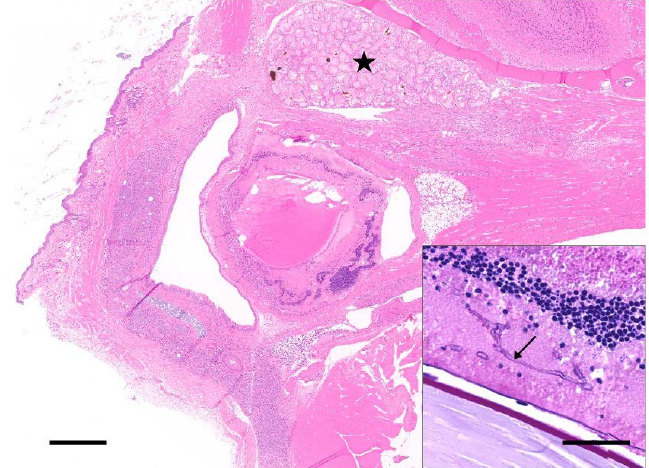
Figure 4. Severe ocular and periocular lesions after retro-orbital bleeding. Example of a severe case of ocular and periocular damage associated with retro-orbital bleeding in a mouse. The eye is small and shrunken ( phthisis bulbi ) with marked intraocular inflammation and intralesional fungal hyphae (black arrow, inset). The periocular tissues are severely inflamed and the Harderian gland is diffusely necrotic (black star). Left scale bar, 500 µ m; Inset scale bar, 50 µ m. Section in the inset is stained with a Periodic acid-Schiff (PAS) stain.